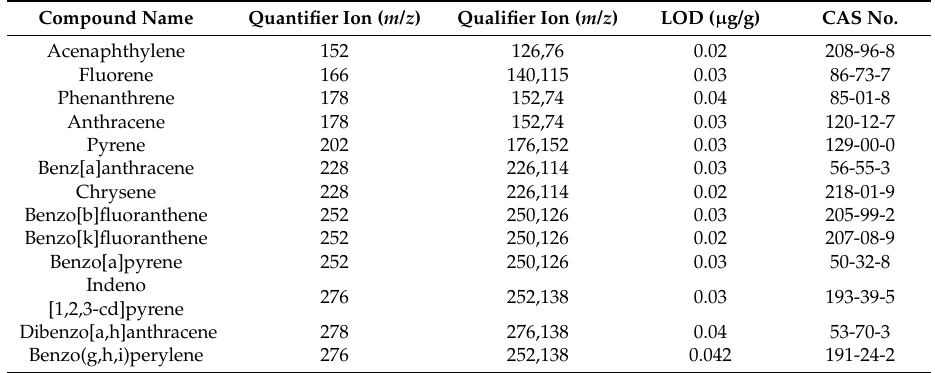
Table 2. Quantifier ions and qualifier ions used in the selected ion monitoring of PAHs by gas chromatography-mass spectrometry.